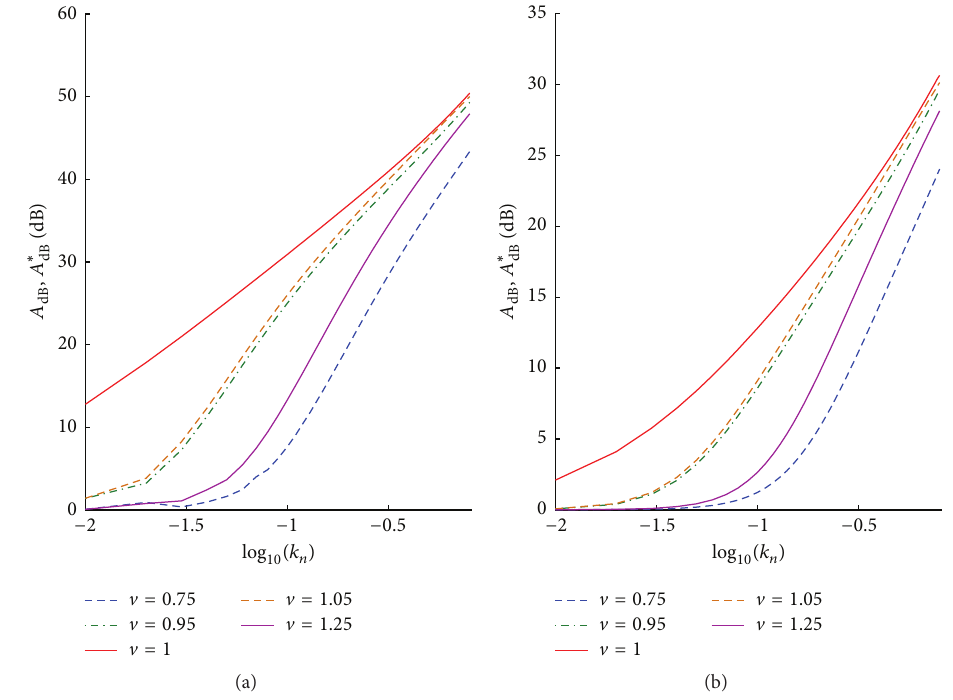
Figure 7: Relationship between 𝐴 dB or 𝐴 ∗ dB and log 10 𝑘 𝑛 for different 𝜉 𝑛 values: 0.1% (a) and 1%